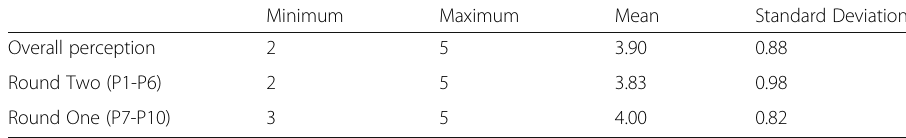
Table 4 The overall perception of WeChat ’ s productivity in Learning Chinese Minimum Maximum